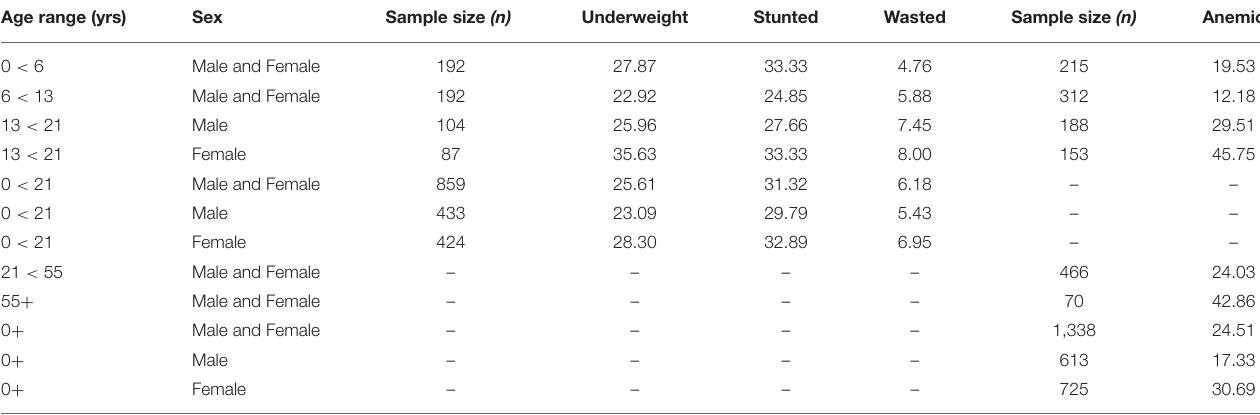
TABLE 5 | Percentages of individuals ( n = 1,750) classified as stunted, underweight, wasted, and anemic in the 13 communities surveyed near the Masoala National Park (2015) † . Age range